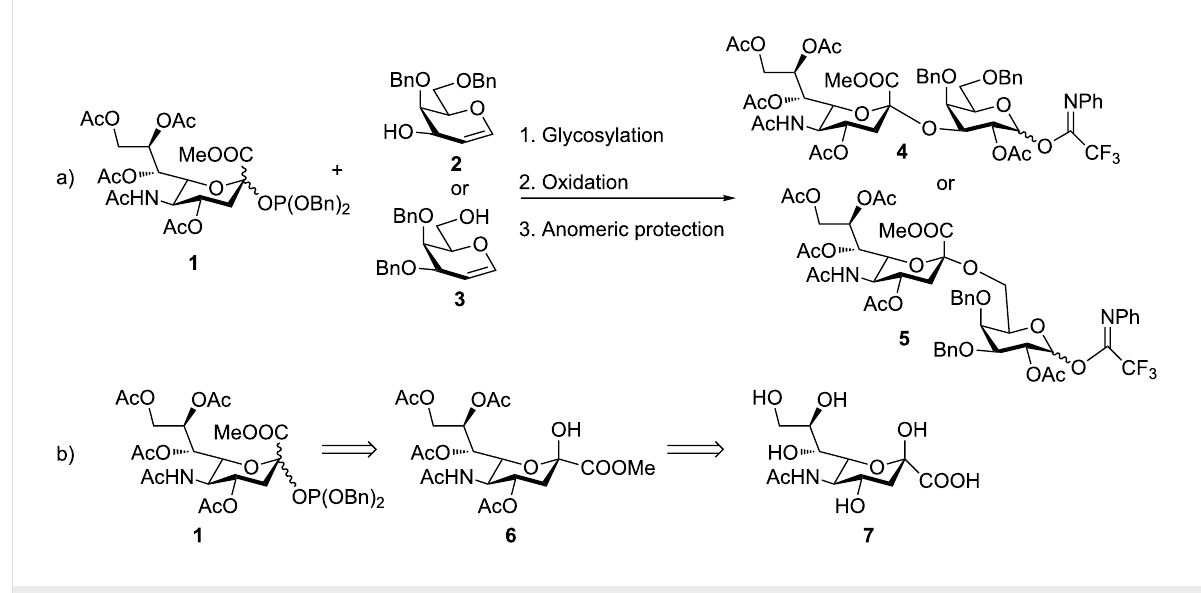
Figure 1: (a) Synthesis sequence for the preparation of building blocks 4 and 5 ; (b) Retrosynthetic analysis for the preparation of 1